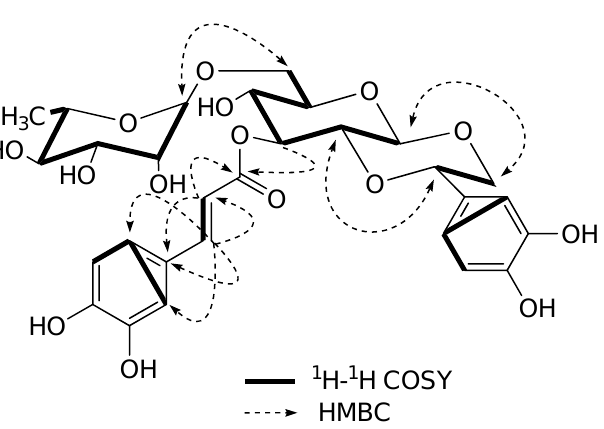
Figure 2. Key 1 H- 1 H COSY and HMBC correlations of 1